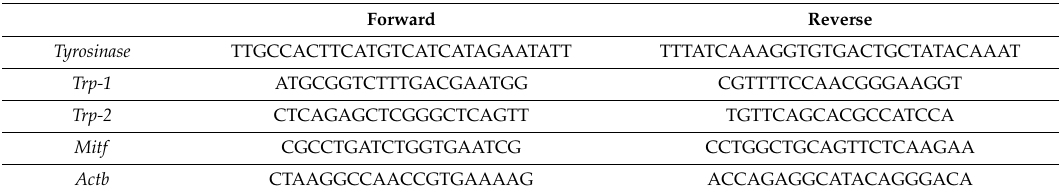
Table 1. Primers used for real-time